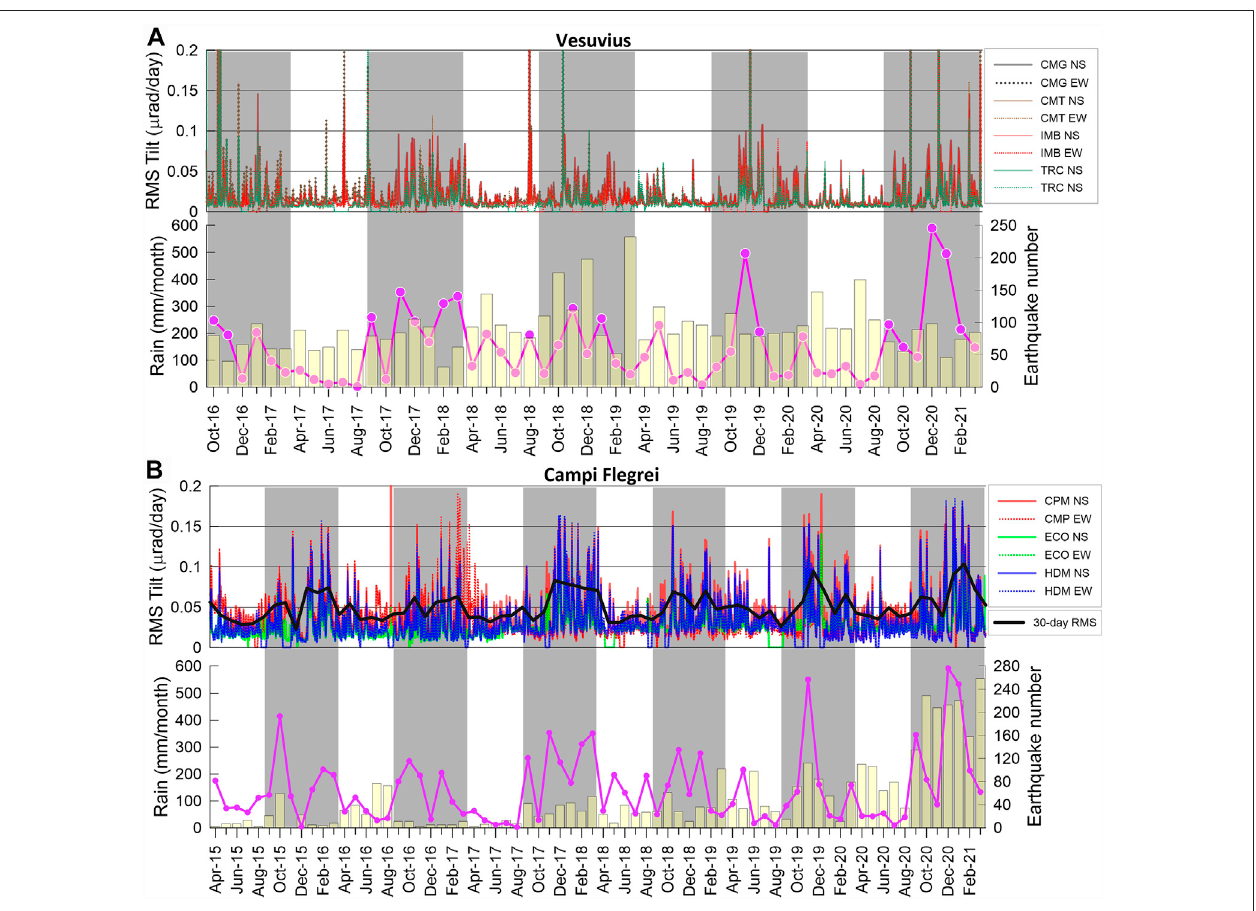
FIGURE 2 | Daily RMS tilt and monthly distribution of rainfall (purple line) and earthquakes (yellow bars) at Vesuvius (A) and Campi Flegrei (B) . The light-grey boxes in the background mark the wet season of the hydrological year. For Campi Flegrei, the RMS tilt calculated over a 30-day time window and averaged over the components of all instruments is also shown (black line)